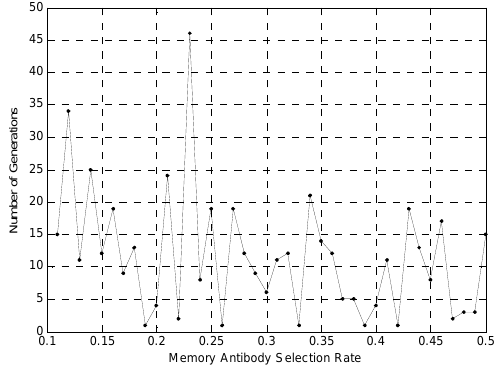
Fig. 15. Sensitivity of Memory Antibody Selection Rate R m